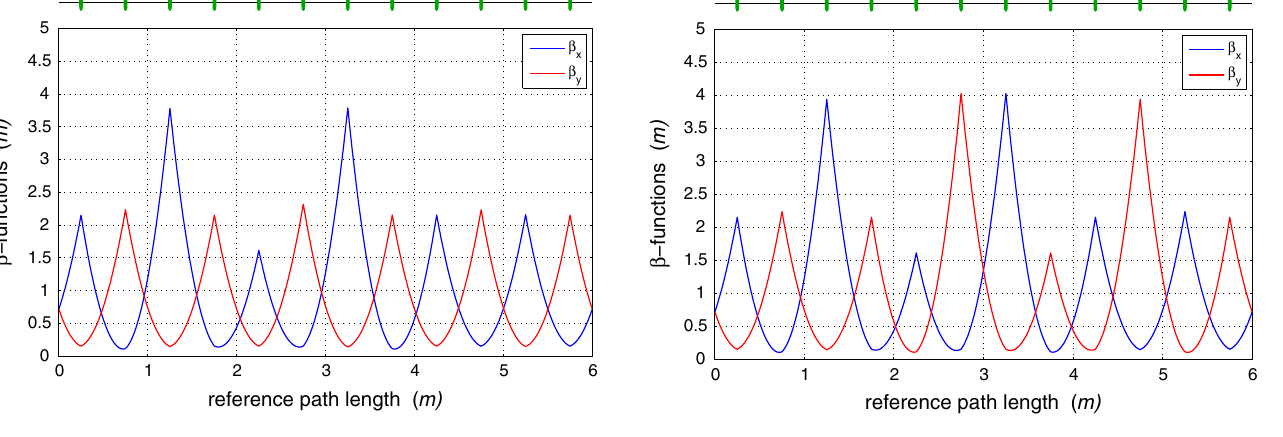
FIG. 1. Betatron functions along the phase advance scan beam ¼ 60 (cid:8) , (cid:8) ¼ 0 (cid:8) . line for (cid:8) x y